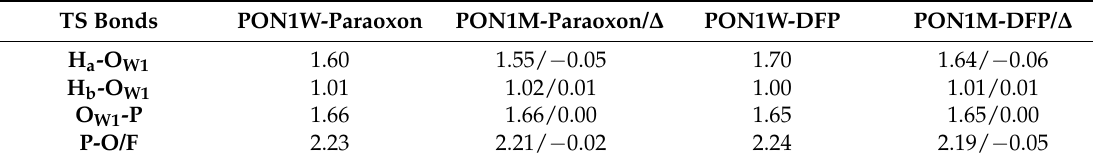
Table 2. Important bond distances of TS in the PON1W-Paraoxon, PON1M-Paraoxon, PON1W-DFP, and PON1M-DFP models. “ ∆ ” is the difference relative to the wild type models. Distances are in angstroms.